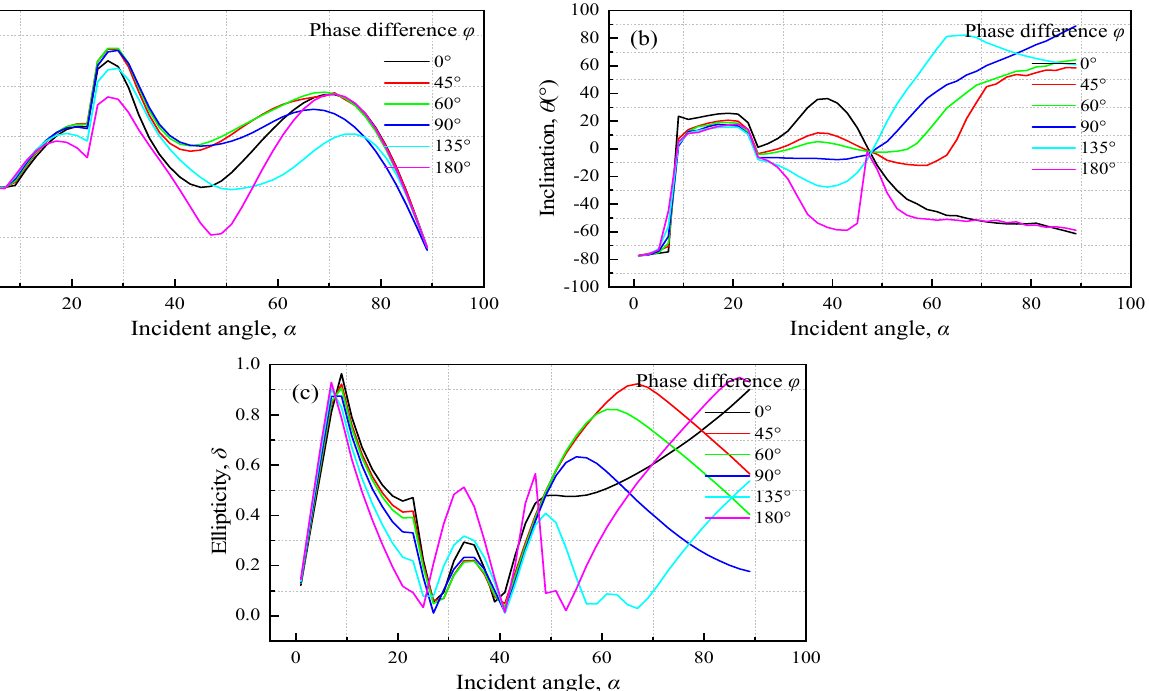
Figure 11. Variation of characteristic parameters of elliptical stress path with the incidence angle for various phase differences.